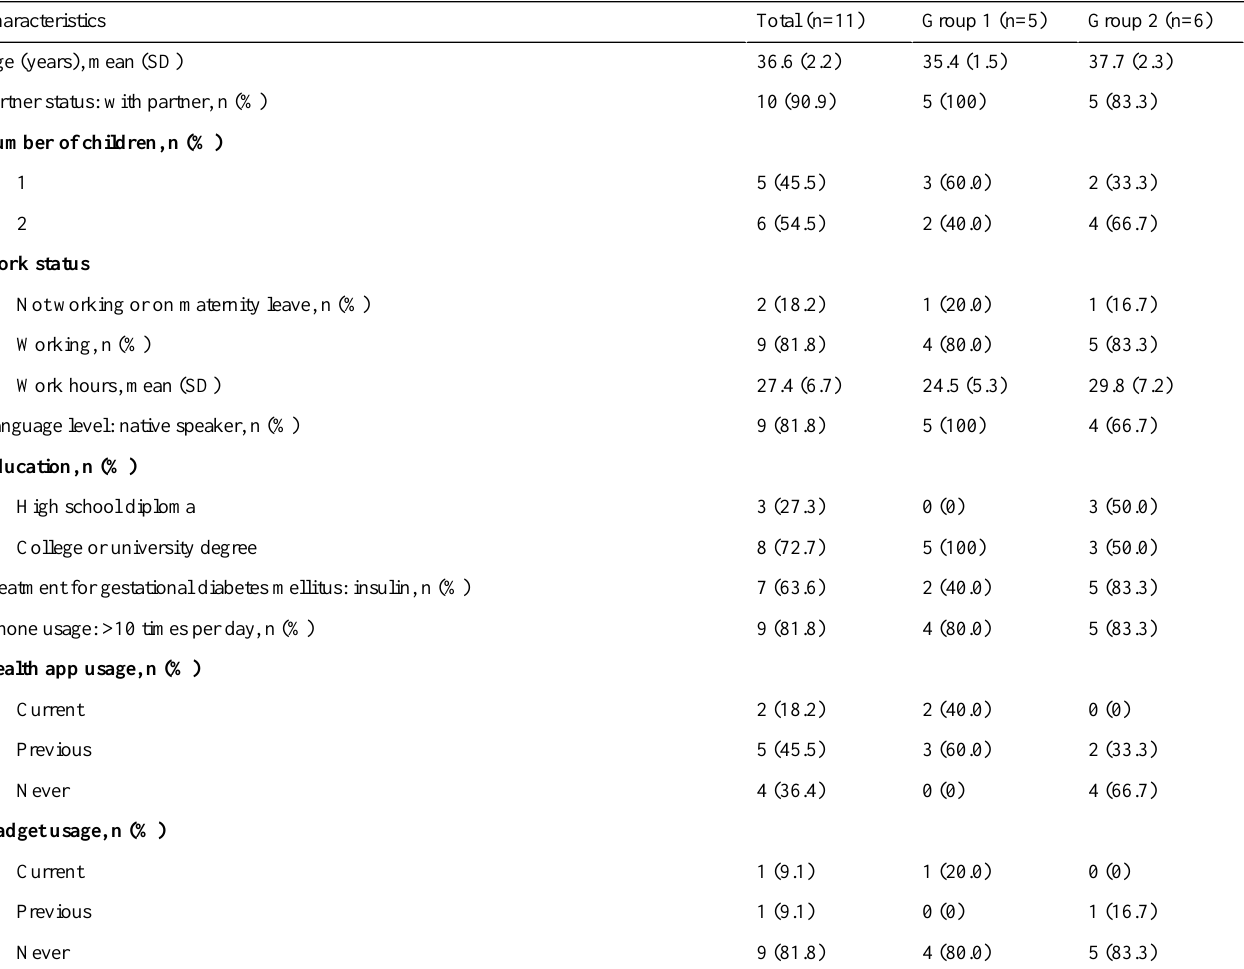
Table 3. Demographic characteristics of participants in the TRIANGLE user